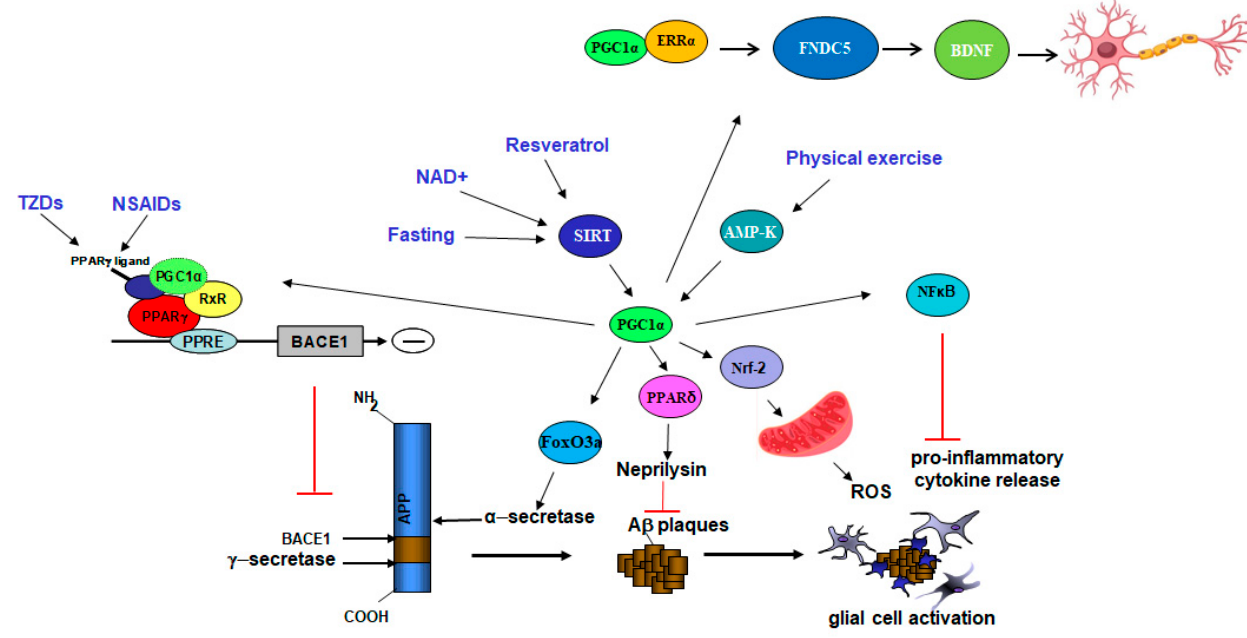
Figure 1. Model showing the mechanistic effects of PGC1 α as therapy in AD. Activation of PGC1 α via interventions (in blue) such as exercise, fasting, or treatments (genetic and pharmacological) can lead to neuroprotection in AD by targeting different transcriptional pathways. Binding to PPAR γ results in changes in the processing of the amyloid-precursor protein (APP) by reducing BACE1 transcription and A β generation. PGC1 α can affect A β degradation by increasing neprilysin activity. In addition, the expression of neurotrophic molecules, such as sAPP α (by increasing α -secretase expression) and BDNF, are enhanced by PGC1 α . Lastly, the levels of pro-inflammatory cytokines and reactive oxygen species (ROS) are also modulated by PGC1 α . Adapted from Katsouri et al, 2016 (reference [38]).